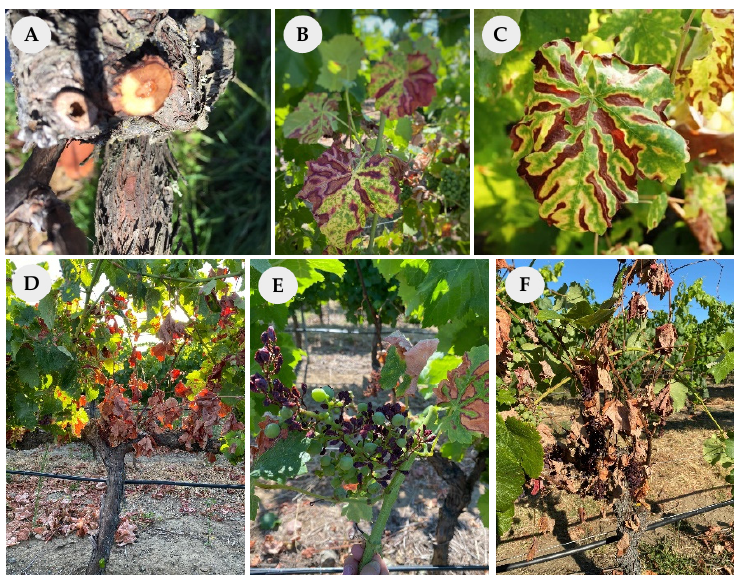
Figure 1. Grapevine trunk diseases general symptoms: wood discoloration and necrosis ( A ), interveinal discolorations, chloroses and necrosis on leaf blades, affecting all or part of the grapevine foliage ( B – D ), stunted growth ( E ), dieback, and the eventual death of symptomatic grapevines ( F ). Pictures were taken in the frame of this study.